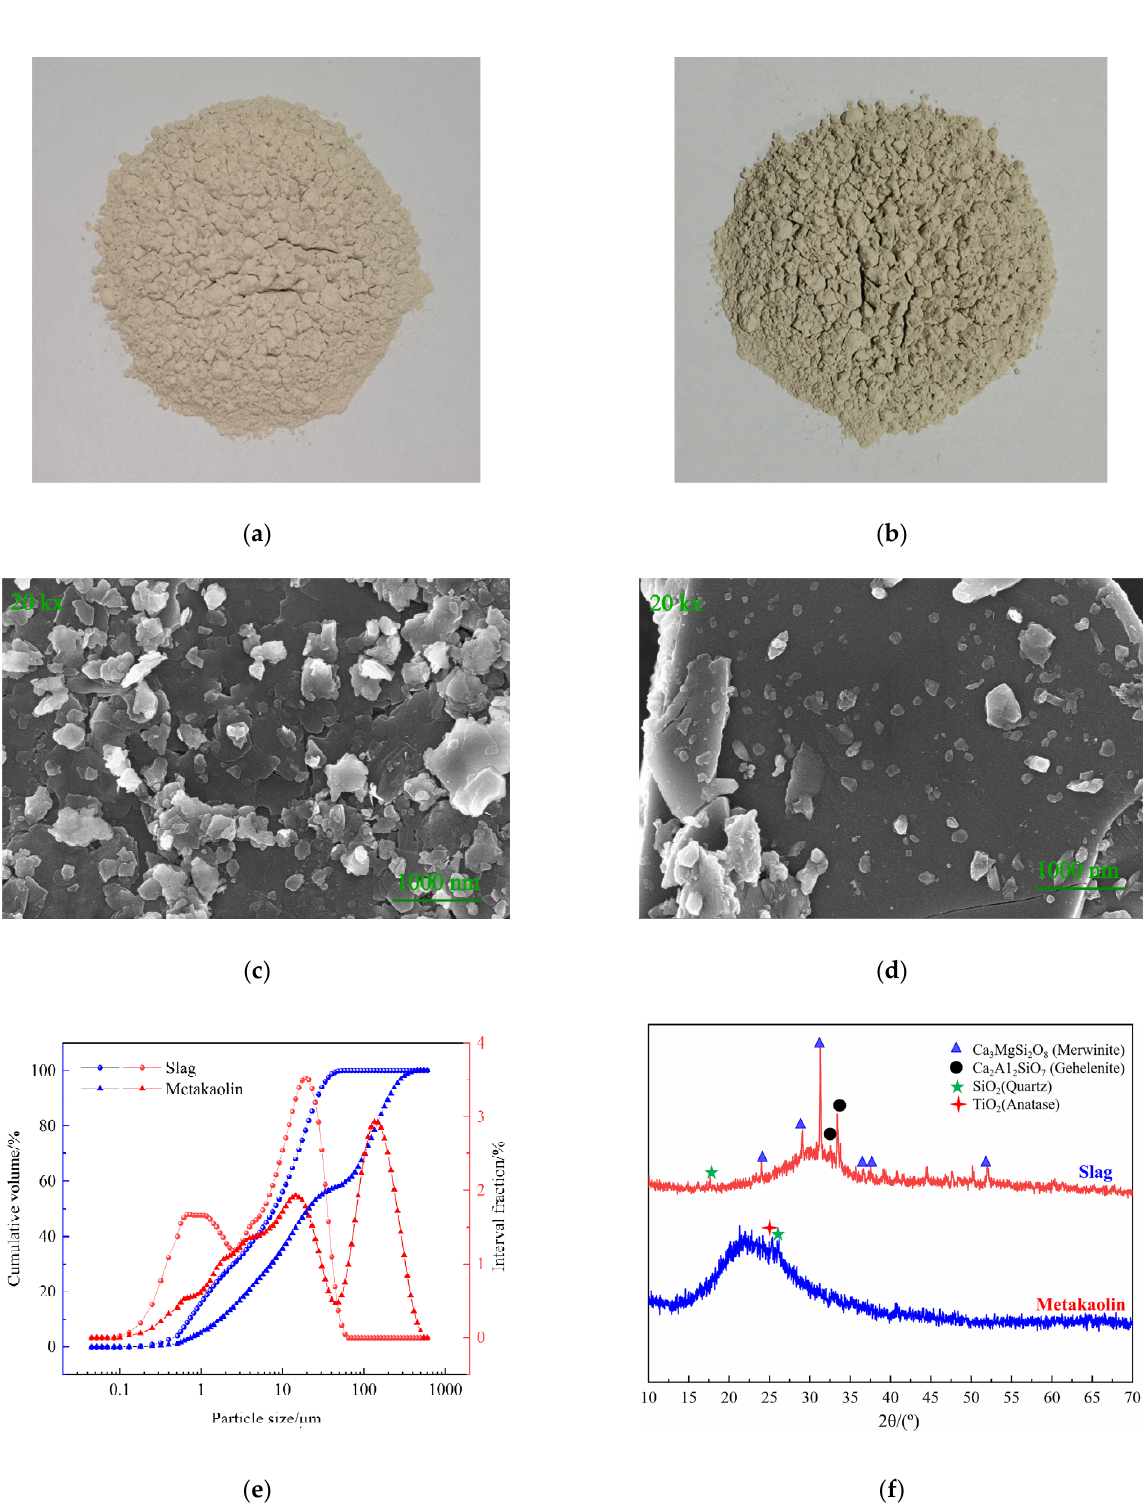
Table 1. Chemical composition and physical index of metakaolin and slag.